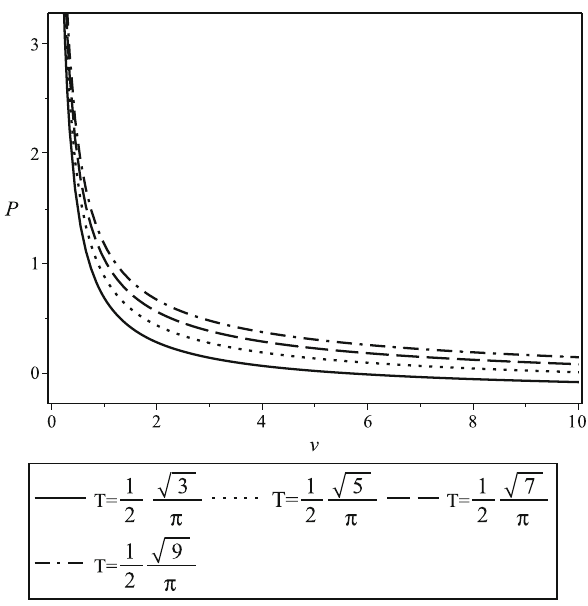
Fig. 9 Location of the roots ξ 2 for the RN black hole as a function of Q , M